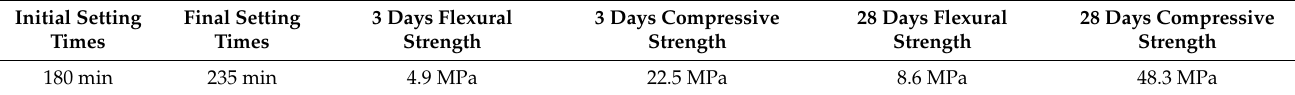
Table 2. Cement physical properties.